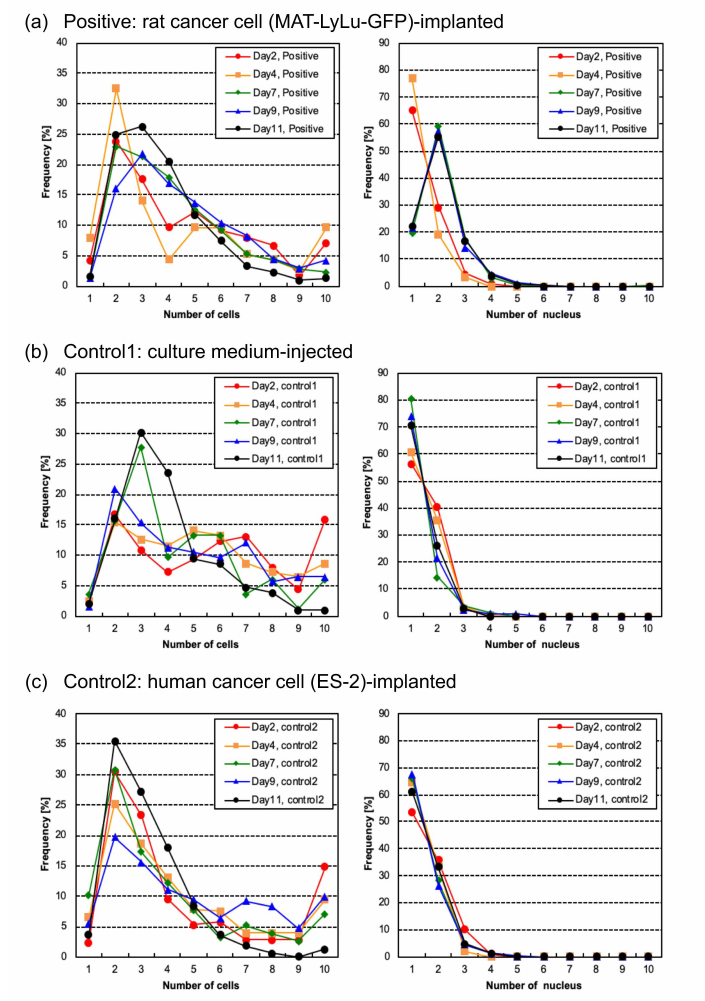
Figure 9. Time-course change of cell number and nucleus number distributions in positive ( a ), control 1 ( b ), and control 2 ( c ) blood of the same samples as in Figure 4. Each size distribution map indicates 2, 4, 7, 9, or 11 days after the implantation of rat cancer cells ( a , positive), culture medium ( b , control 1), or human cancer cells ( c , control 2). Measurements were performed for six rats for positive cases and three for controls. Left graphs are the cell number distribution from BF images and right graphs are the nucleus number distribution from FL